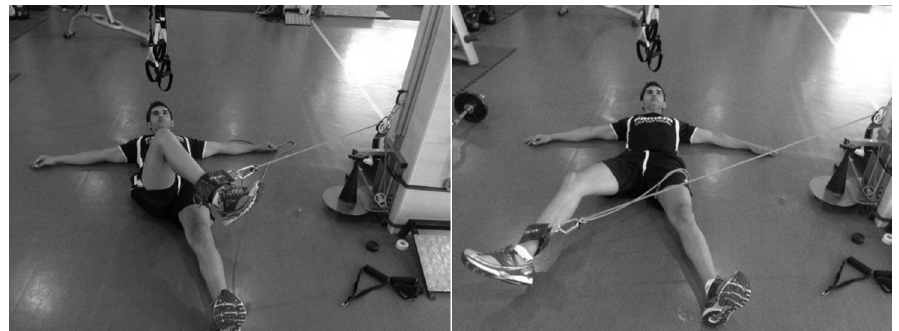
Figure 2. Rotary inertial device abductor exercise.